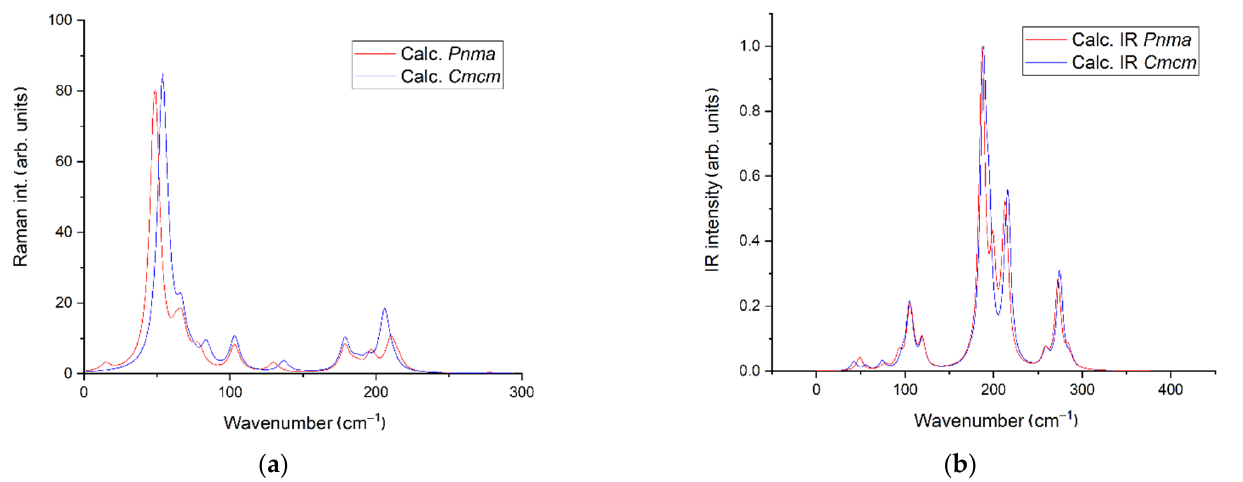
Figure 3. Simulated Raman ( a ) and infrared spectra ( b ) for EuScCuSe 3 in its two possible structures. All calculations were performed for T = 298 K.